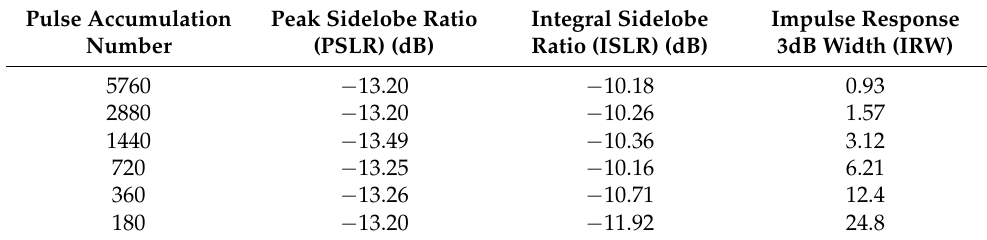
Table 1. Single point simulation performance